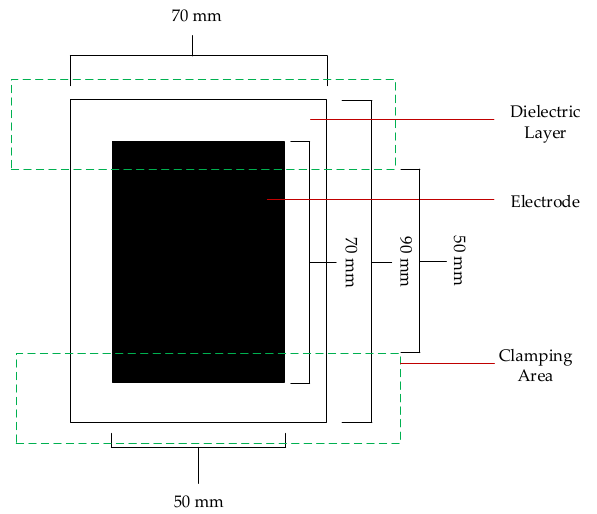
Figure 2. Layout of the finished DEA with corresponding sizes and marked clamping areas.